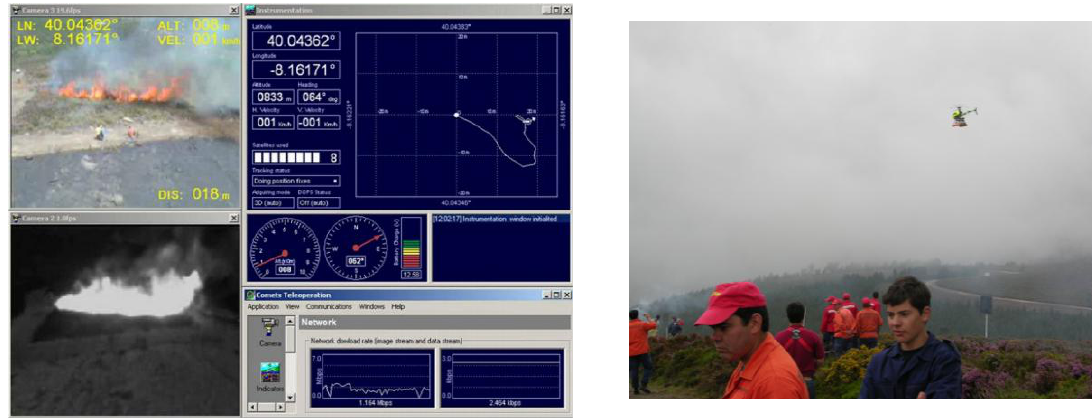
Figure 14. (Left) Screenshot of the UAS station during a field experiment. (Right) Picture taken during the